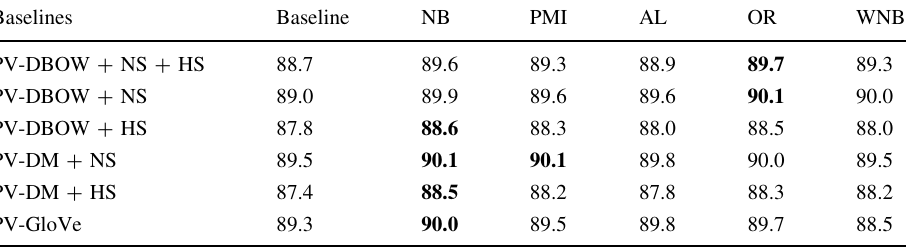
Table 3 Effectiveness of weighting schemes on PV and PV-GloVe